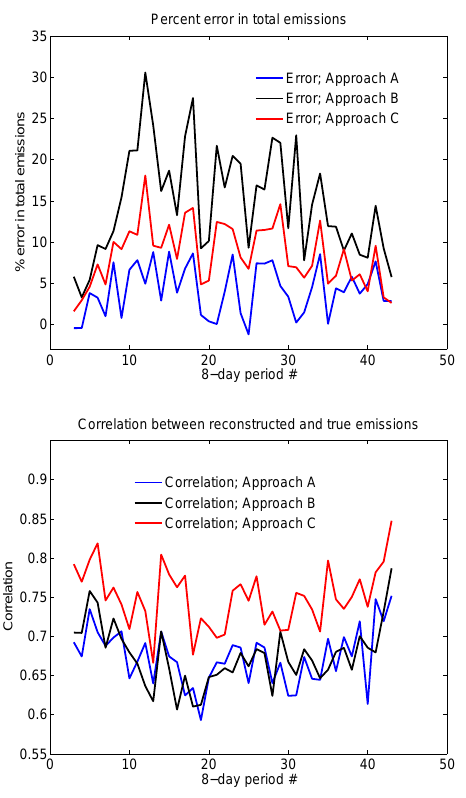
Figure 4. Reconstruction error (left) and correlation between the true and estimated emissions, using Approaches A and C, for the Northeast (NE) and Northwest (NW) quadrants. We see that Approach C, which includes information from f pr , leads to lower errors in both the quadrants and better correlations in the less instrumented NW quadrant.